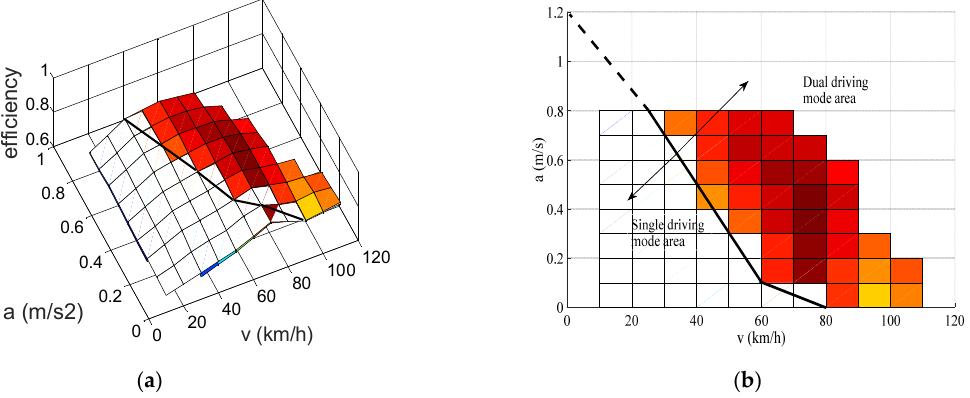
Figure 8. Efficiency comparison and switching rule under Condition 2. ( a ) Efficiency comparison under Condition 2; ( b ) Switching rule under Condition 2.